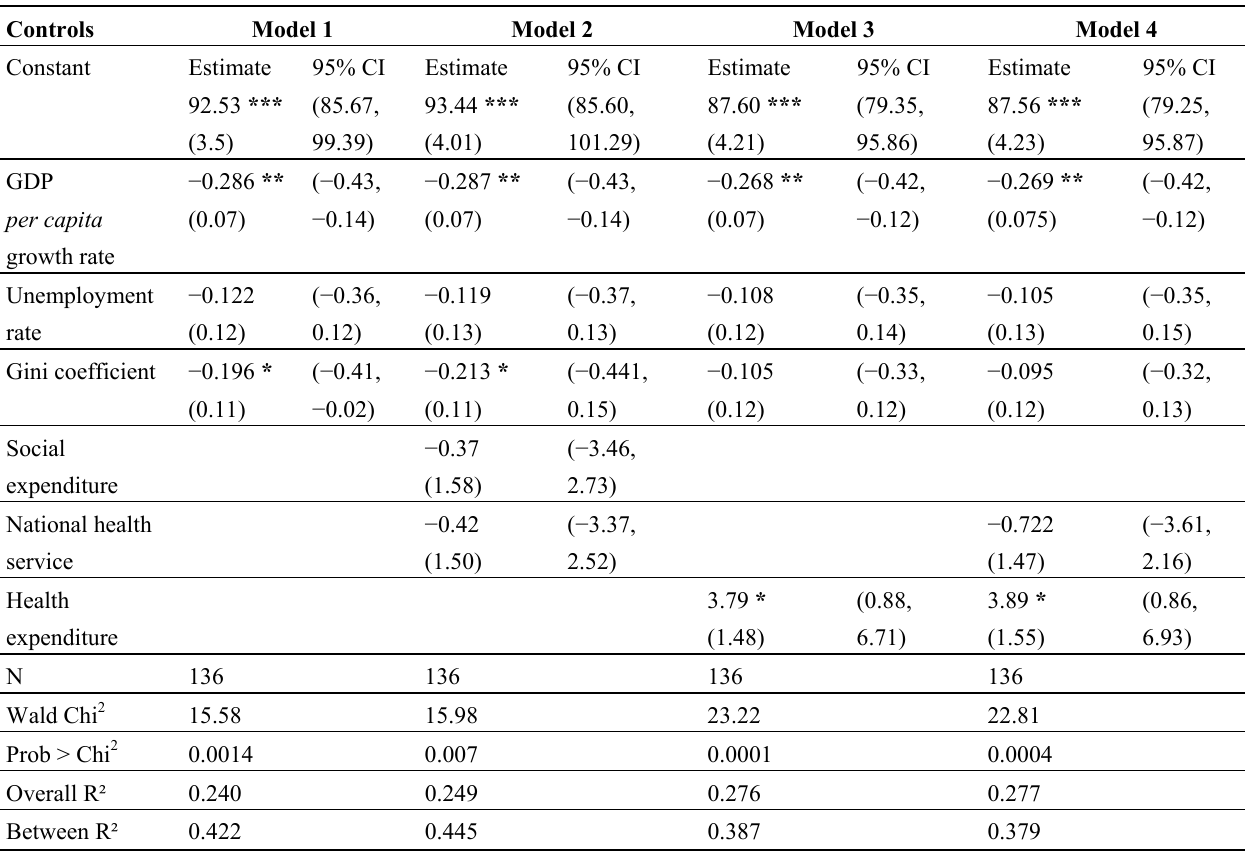
Table 2. Longitudinal results: 1980–2010-Health Index as the dependent